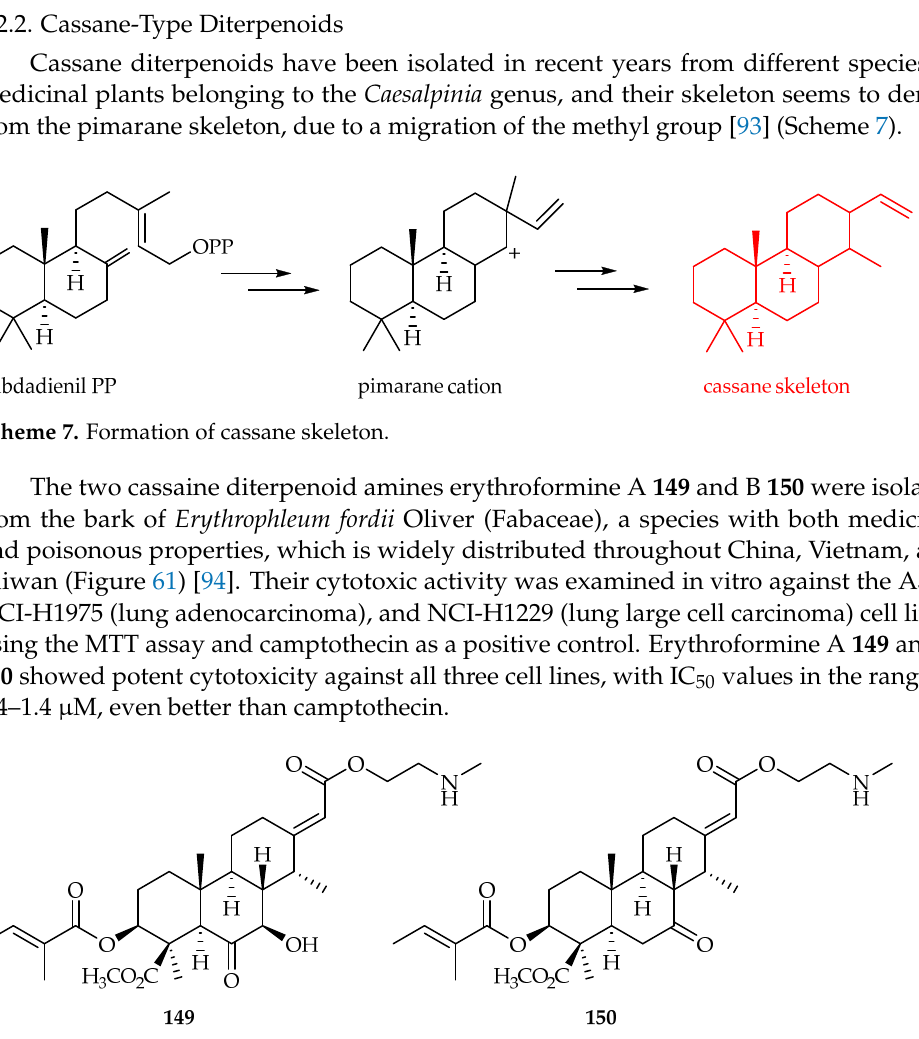
Figure 60. Structure of leriifolione 1 47 [91] and salvimulticanol 148 [92].